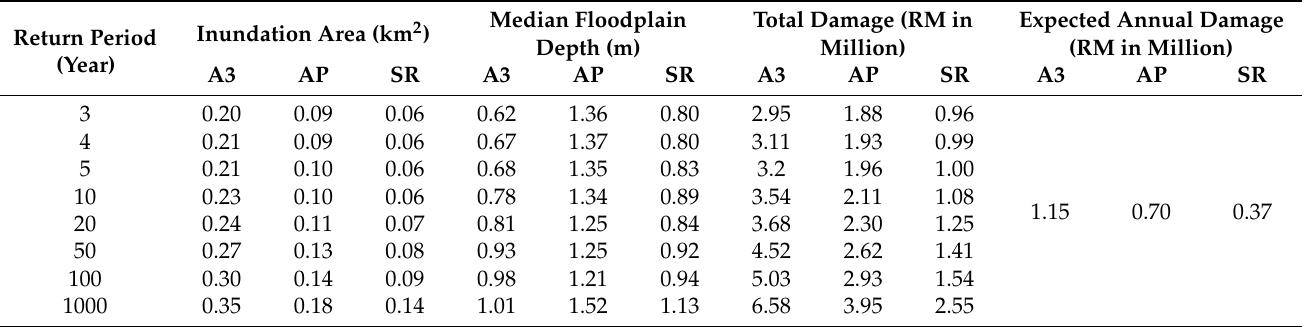
Table 2. Results of total inundation area, median flood depth, total damage and flood risk in expected annual